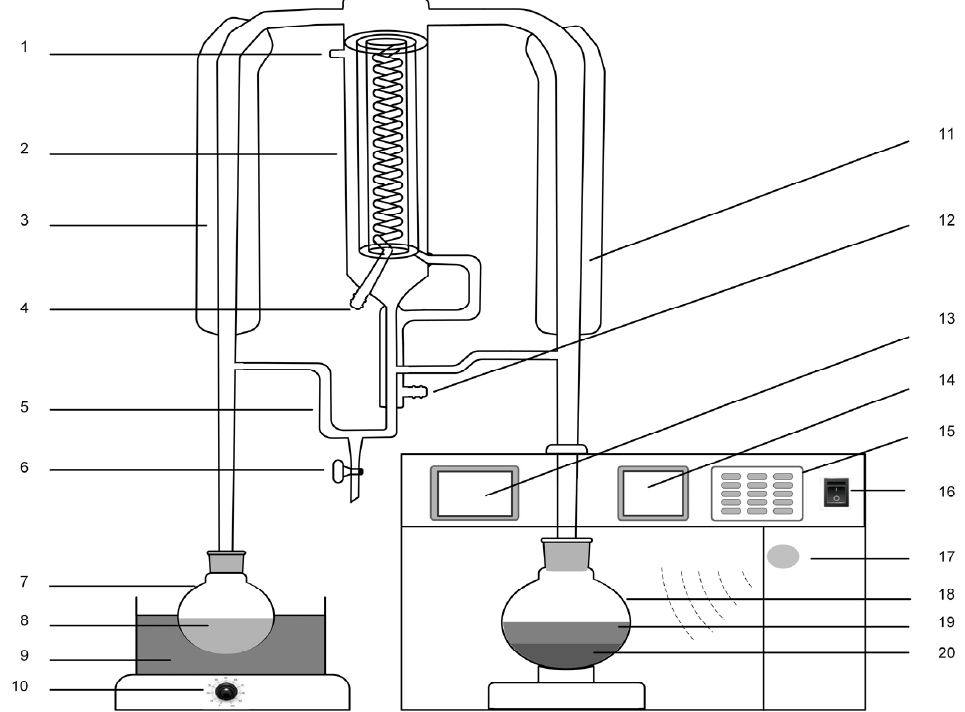
Figure 1. Schematic representation of the MA-SDE device: (1) air-vent; (2) condenser; (3) vacuum tube; (4) water outlet; (5) extraction cell; (6) valve cock; (7) flask I; (8) organic solvents; (9) water bath; (10) power switch; (11) vacuum tube; (12) water inlet; (13) video display; (14) program display; (15) control panel; (16) power switch; (17) microwave generator; (18) flask II; (19) water; and (20) plant materials.